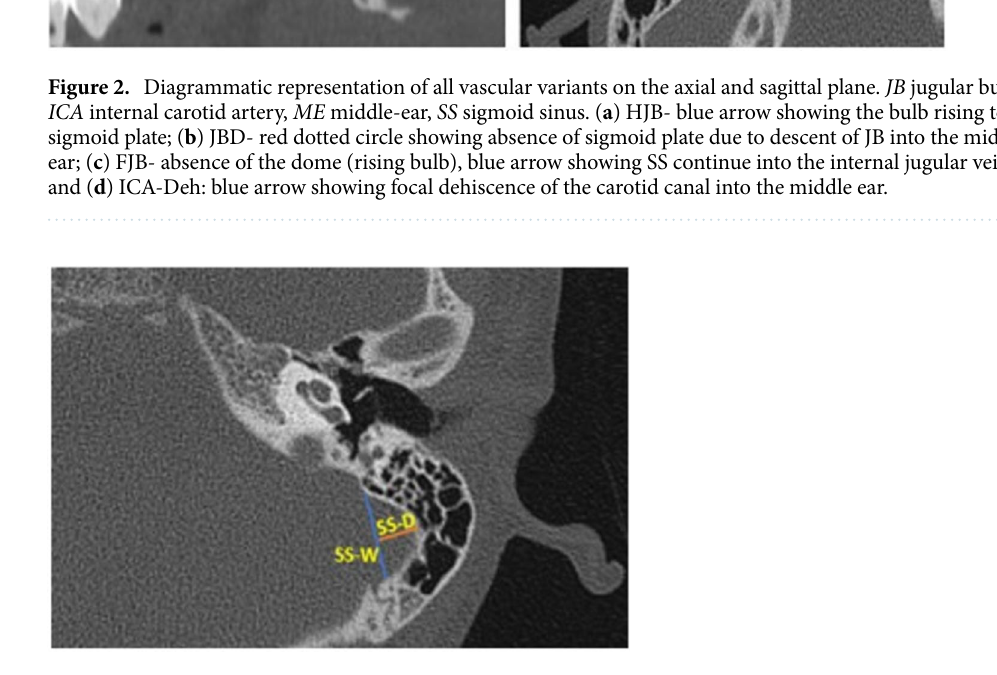
Figure 3. Diagram showing the measurements of sigmoid sinus width and sigmoid sinus diameter. SS sigmoid sinus, W width, D diameter. SS-W (blue line) and SS-D (orange